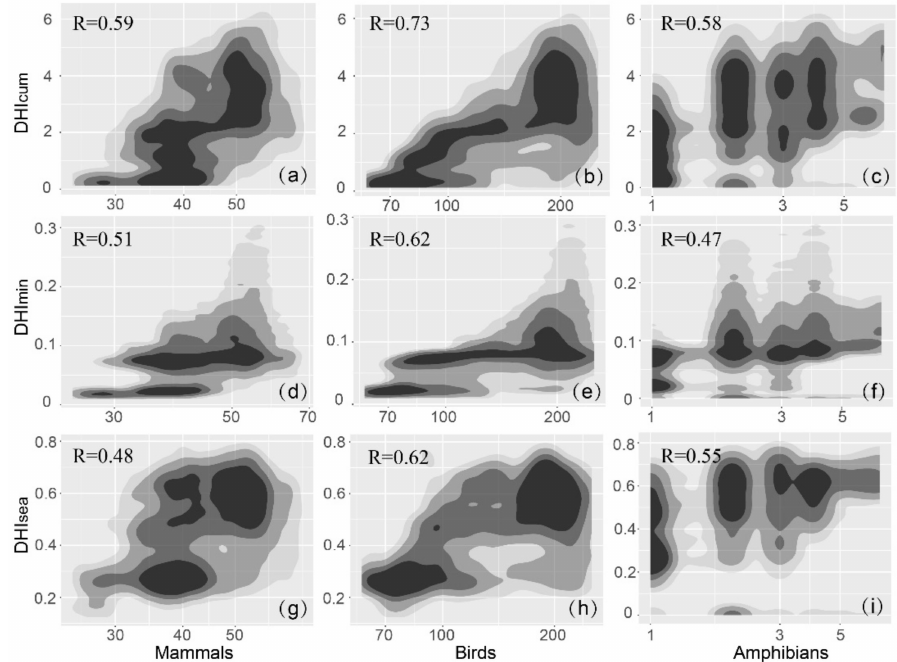
Figure 5. The relationship between species richness and DHIs (2018) in terms of frequency distribu- tions. DHI cum with ( a ) mammals, ( b ) birds, and ( c ) amphibians. DHI min with ( d ) mammals, ( e ) birds, and ( f ) amphibians. DHI sea with ( g ) mammals, ( h ) birds, and ( i ) amphibians. The darker the color, the higher the density. Black represents high